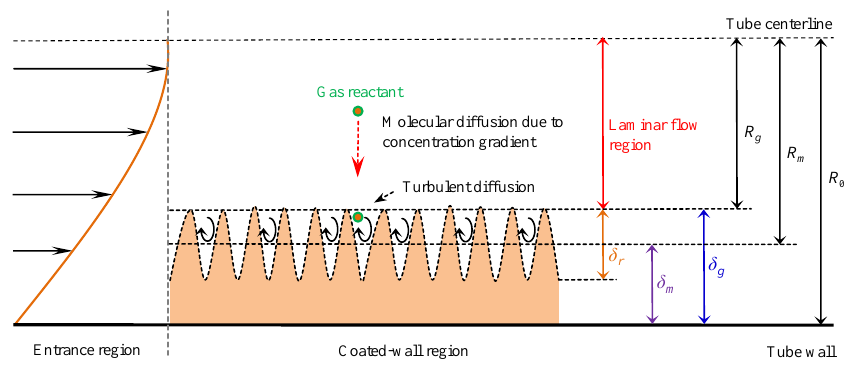
Figure 4. Illustration of the variables used for the CKD-LT and KPS-LT methods: δ r , roughness height; δ m , mass-based coating thickness; δ g , geometric coating thickness; R g , calculated flow tube radius based on δ g ; R m , calculated flow tube radius based on δ m ; R 0 , flow tube radius without coating.